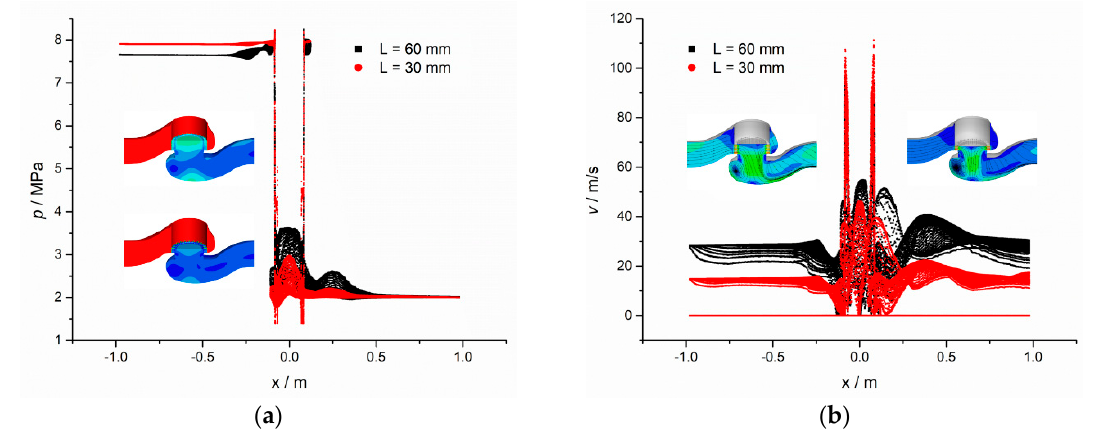
Figure 4. Pressure and velocity variation along the horizontal direction for different valve core displacements ( a ) pressure; ( b ) velocity.